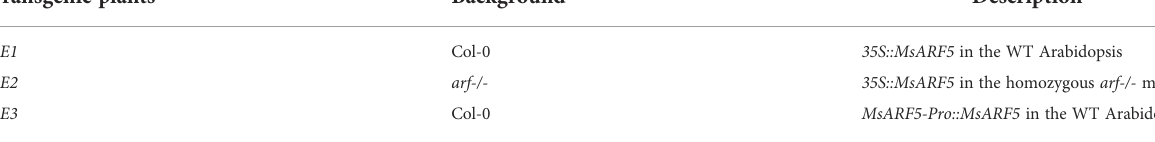
TABLE 1 Transgenic lines used in this